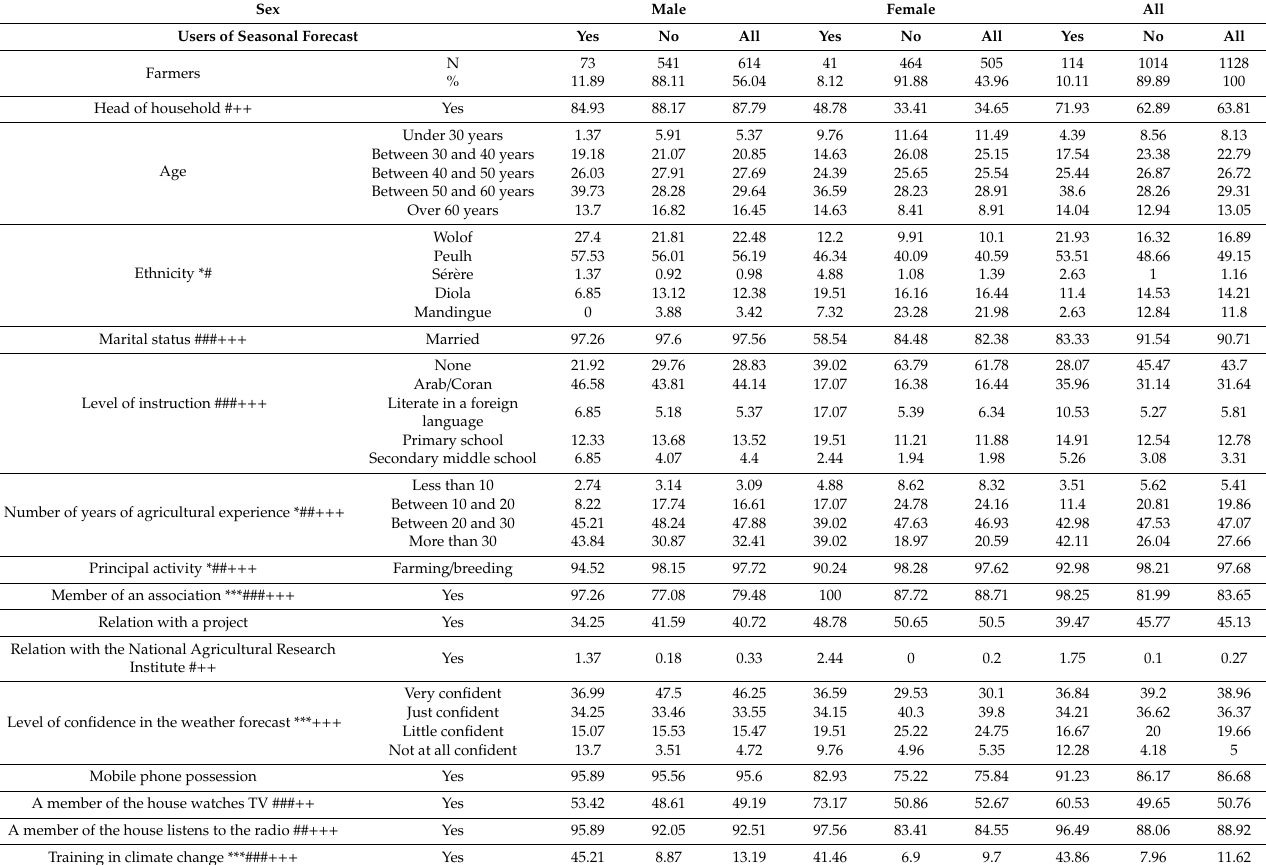
Table 3. Farmers’ socioeconomic characteristics by gender and adoption